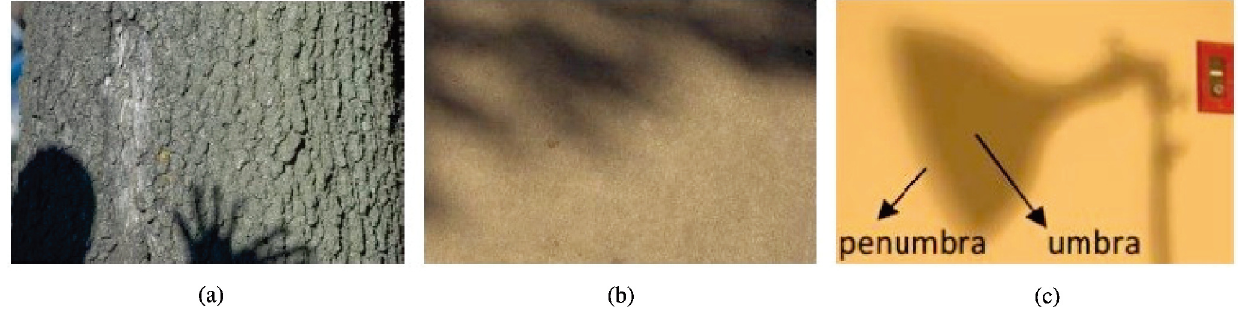
Fig. 2 Types of shadow: (a) hard shadow, (b) soft shadow, (c) shadow regions, umbra and